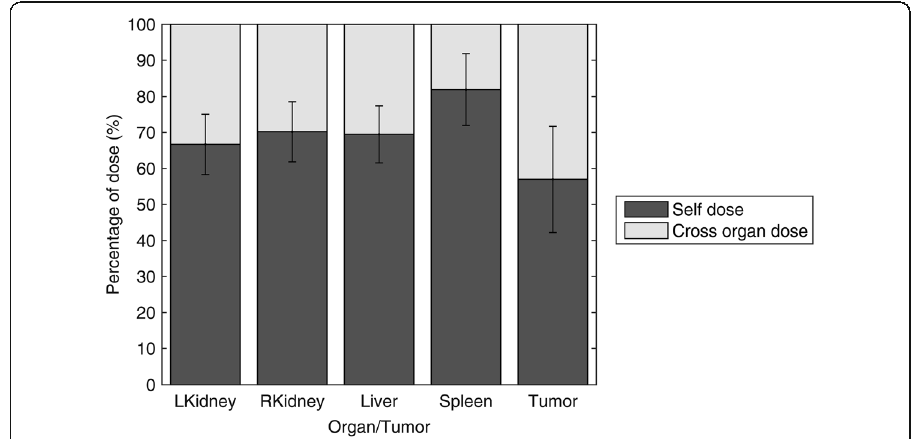
from all patients ’